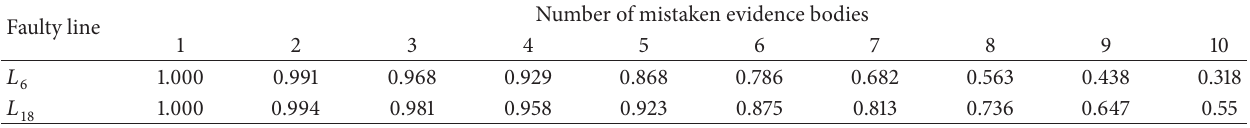
Table 6: WABP performance under mistaken condition A when a fault occurs on 𝐿 6 or 𝐿 18 . Faulty line